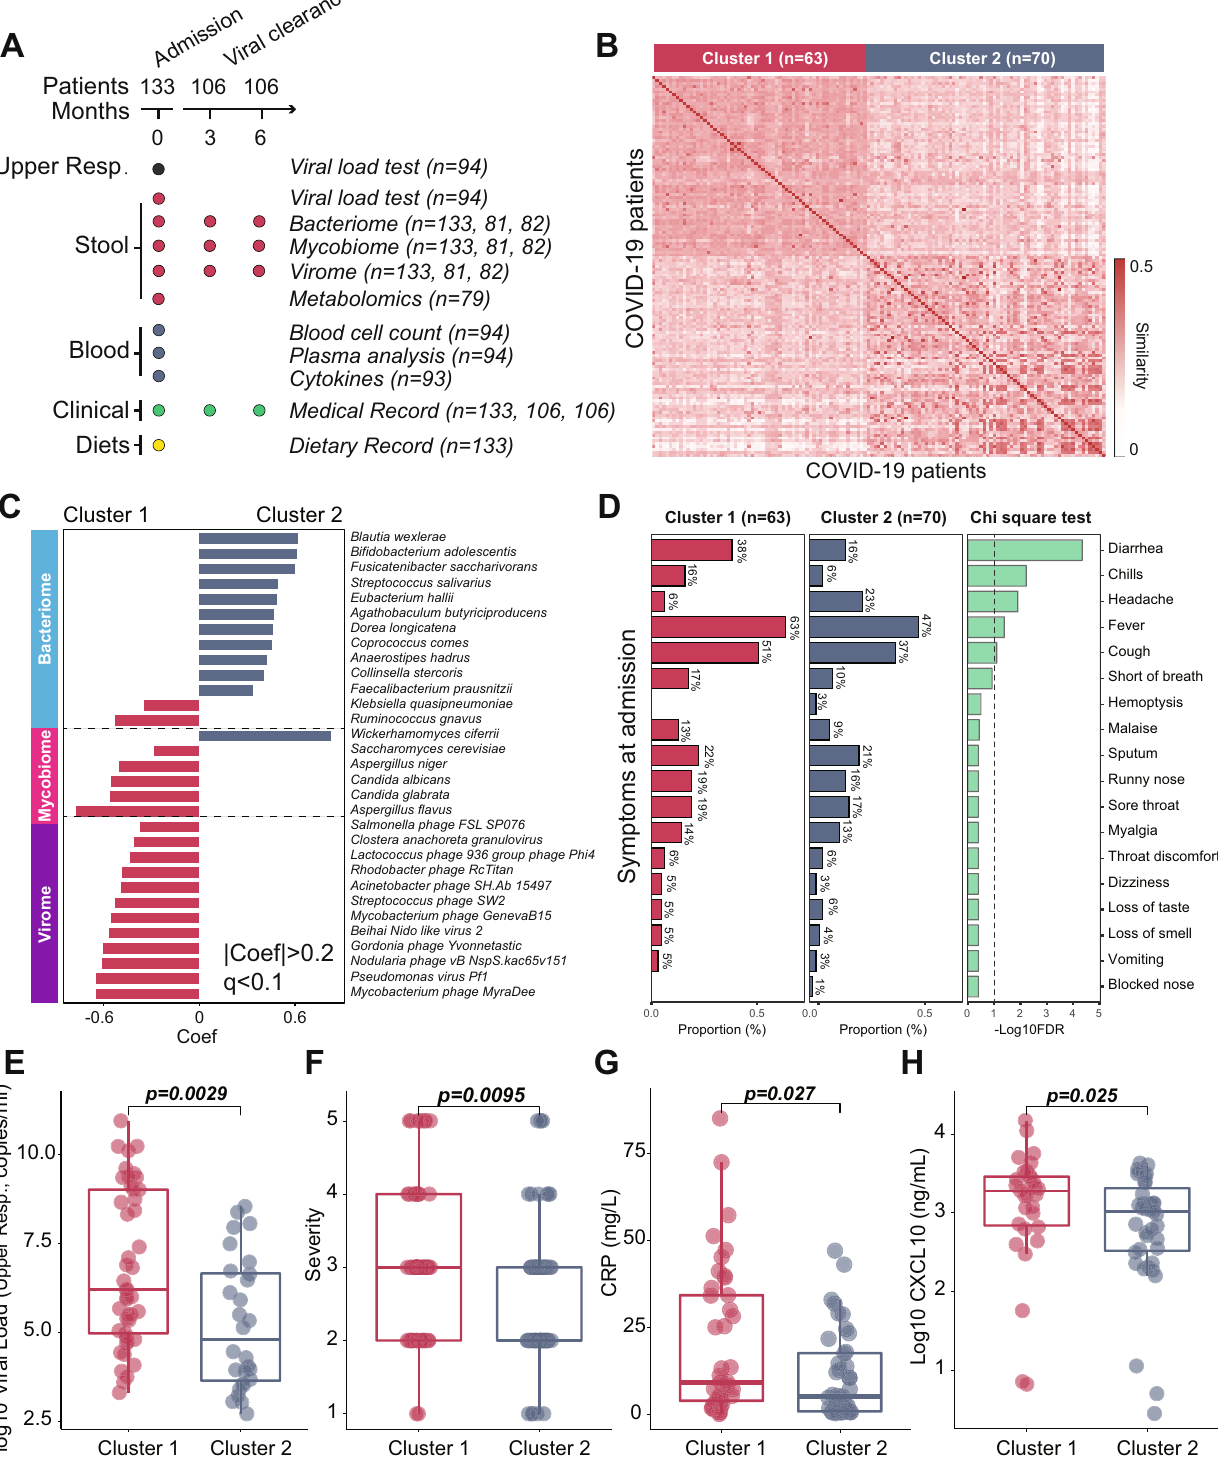
We explored the functional pro fi ling of microbiome signatures in the two clusters and identi fi ed cluster-speci fi c functional signatures Fig. 1C, q < 0.1, fold change >2). Elevated blood urea nitrogen (BUN) (Supplementary Fig. 1C and Supplementary Data 3). For functional levels have been reported to be associated with critical illness and mortality in COVID-19 patients and are predictive of poor clinical outcomes 15,18 . We found that blood urea levels were strongly asso- ciated with the microbiome urea cycle pathway and were higher in COVID-19 patients with severe disease (Supplementary Figs. 1D, E,